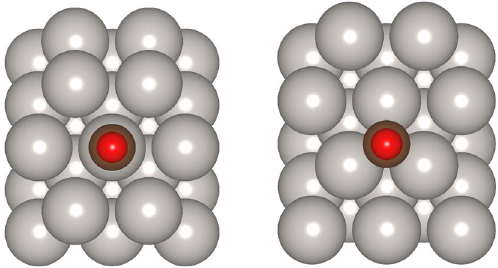
FIG. 8. Schematics of the CO-on-Pt(111) problem: Competi- tion between TOP- and FCC-site adsorption. The image is generated using the VESTA program